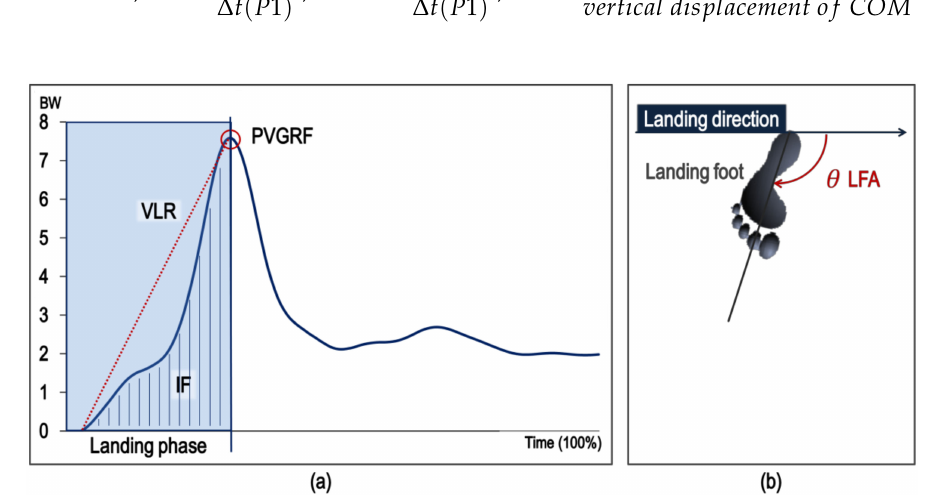
Figure 3. ( a ) Impact variables (impact force (IF), peak vertical ground reaction force (PVGRF), vertical loading rate (VLR)) of vertical GRF during landing, ( b ) landing foot angle (LFA). The SI for analyzing the bilateral (left and right)/ipsilateral (agonist and antagonist muscle) symmetry of the strength of the lower extremity was calculated as follows. As the SI was closer to 0%, it can be evaluated to be more symmetrical. It could range up to 200% [43]. × 100% + X ( X ) L N 2 X L = lower body muscular strength of landing (or agonist), X N = opposite lower body muscular strength of landing (or antagonist